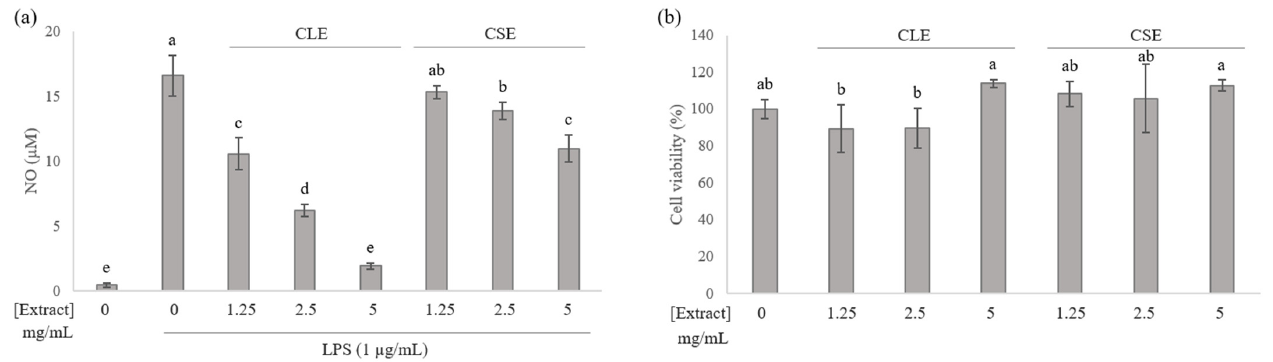
Figure 1. Effect of celery extracts in RAW 264.7 cells on: ( a ) nitric oxide production; ( b ) cell viability. Mean values with different letters were significantly different ( p < 0.05).